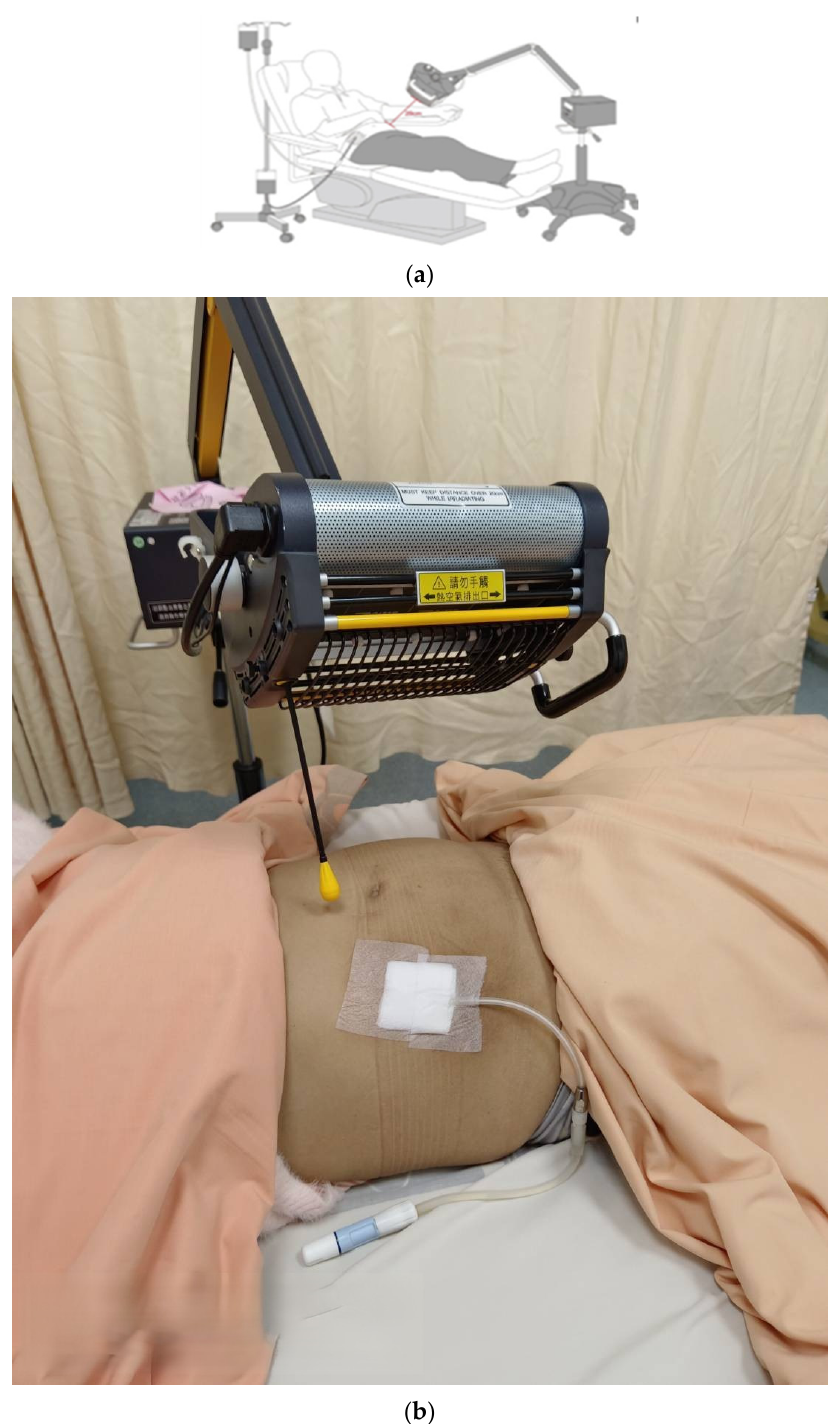
Figure 2. ( a ) FIR therapy set-up during a PD exchange. Abbreviations: FIR: far-infrared; PD: peritoneal dialysis [11]; ( b ) a photo of the FIR therapy at night.